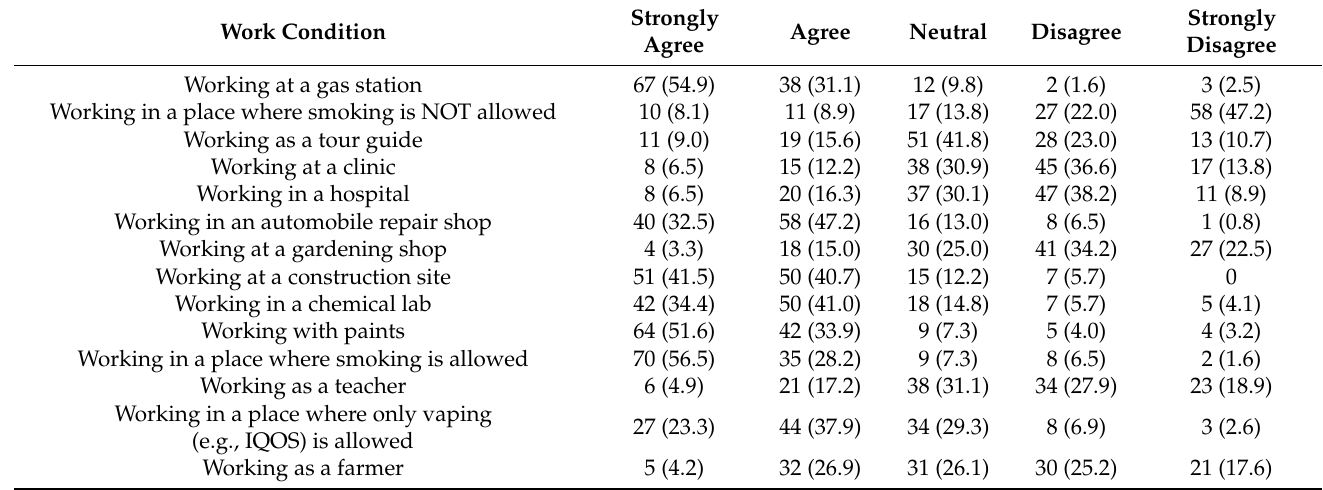
Table 3. Answers to the question “To what extent do you agree that each of the below working conditions is associated with exposure to air pollution”? The answers are reported as true counts